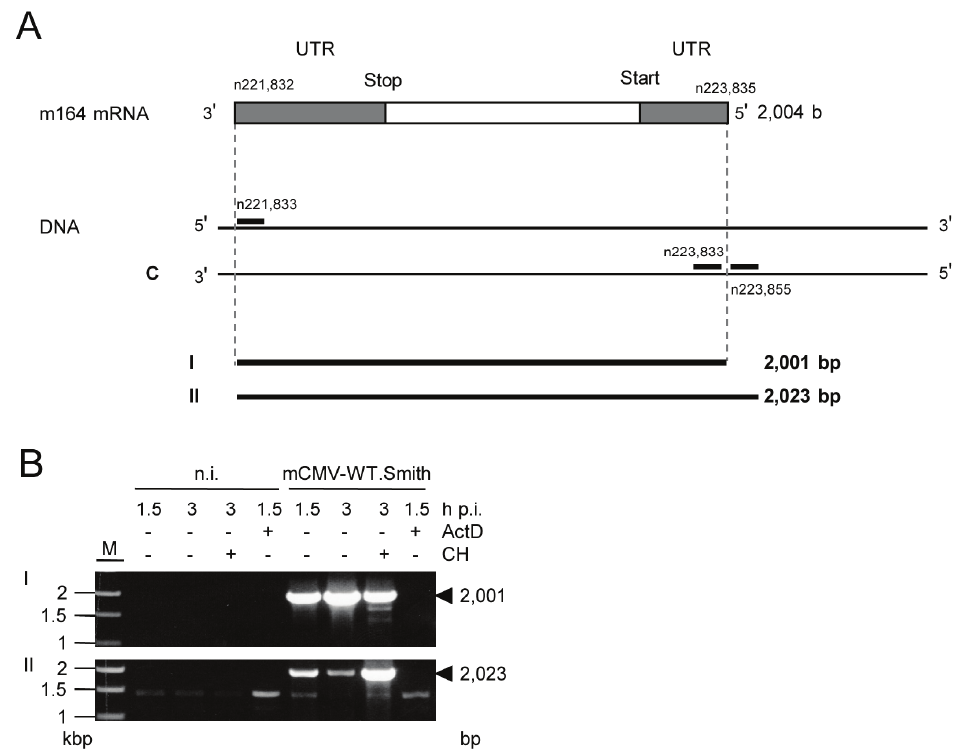
Figure 5. Verification of the m164 IE phase mRNA by RT-PCR. ( A ) Schematic map of the RACE-defined m164 mRNA with its 3'- and 5'-UTRs. RACE analysis (see Appendix Figure A1) predicted an mRNA of 2004 b. Positions of oligonucleotides binding inside or outside of the RACE product are indicated. Calculated sizes of the respective RT-PCR products are shown in lines I and II; ( B ) MEF were infected with mCMV-WT.Smith in presence (+) or absence (–) of ActD (5 µg/mL) or CH (100 µg/mL) as indicated. At 1.5 h or 3 h p.i. total RNA was isolated and subjected to RT-PCRs using oligonucleotides for product I or II (see Appendix Table A1). Amplificates were analyzed on a 1% agarose gel. M, marker; n.i. not infected; bp, basepairs. Controls with no RT step were negative throughout (not shown).